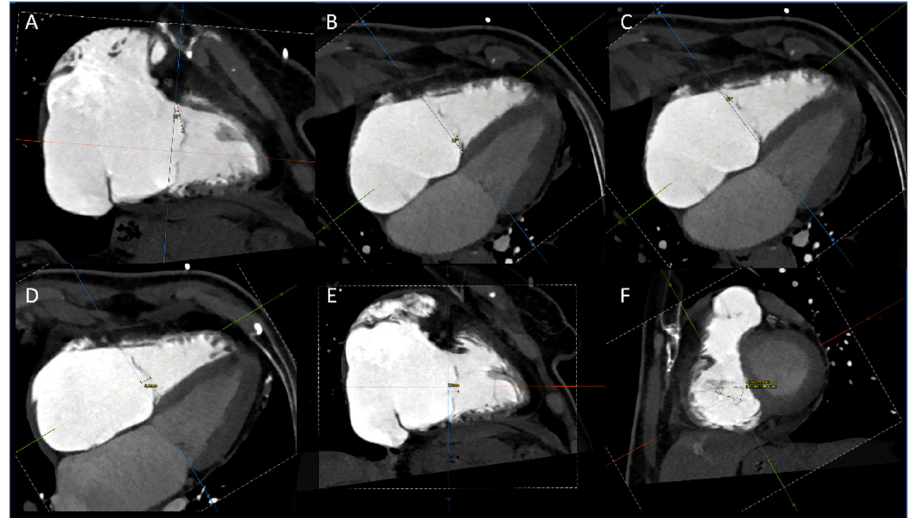
Figure 2. Assessment of leaflets tenting, measuring the degree of tethering of the anterior ( A ), septal ( B ), and posterior ( C ) leaflet; the height of tenting in two-chamber ( D ) and four-chamber ( E ) view; and the anatomical regurgitant orifice area ( F ).